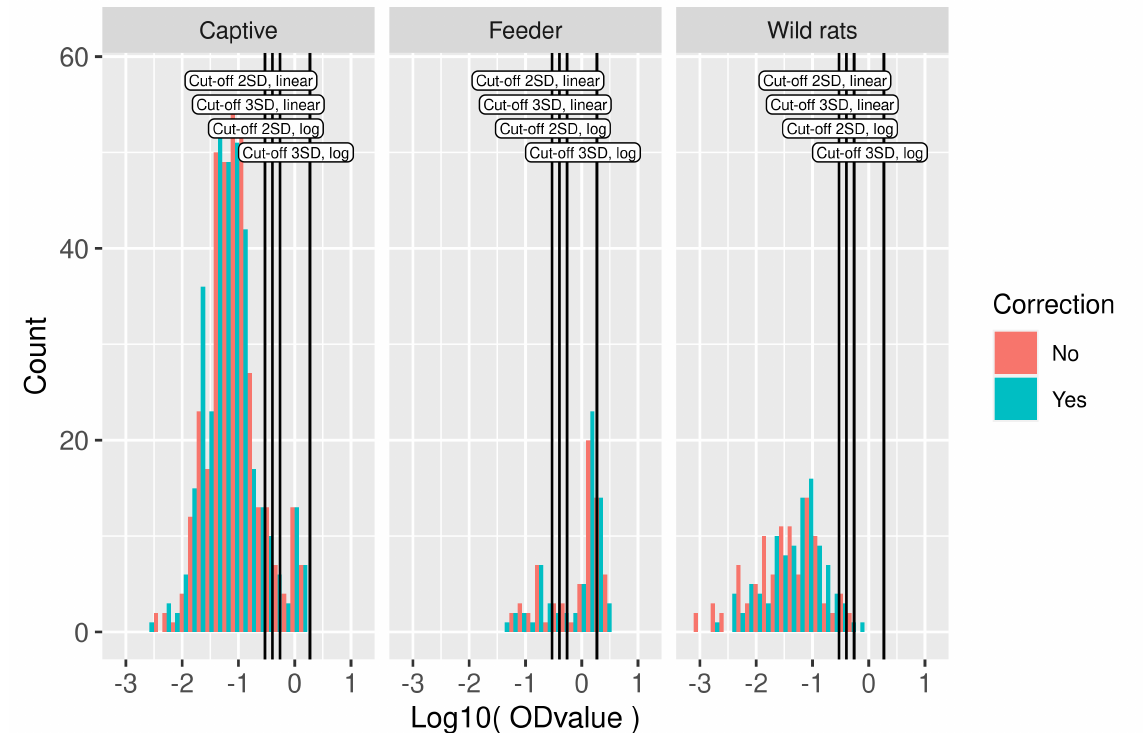
Figure 2. Serological data used in model fitting. Histogram of logOD values by study. Cut-off values based on the mean OD values in the wild rat dataset plus two or three standard deviations in log10-scale and linear scale are indicated by vertical lines. On the y axis, the count is presented, i.e., the number of rats with an OD value within the range of logOD values covered by the width of the